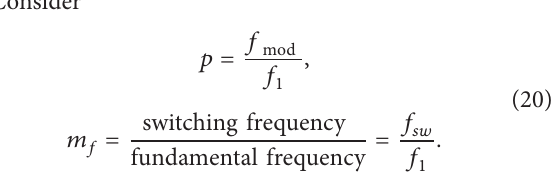
Figure 10: (a) The THD analyses of inverter voltage, (b) inverter current, and (c) the grid or load voltage at 4 kHz switching